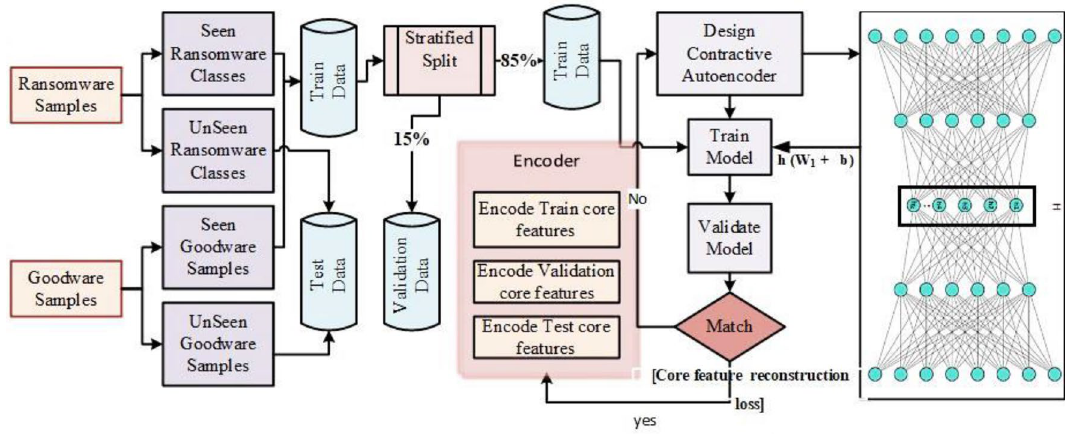
Figure 3. Core feature hunting using